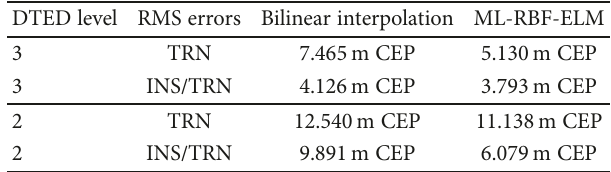
Table 3: Comparison of TRN and INS/TRN RMS